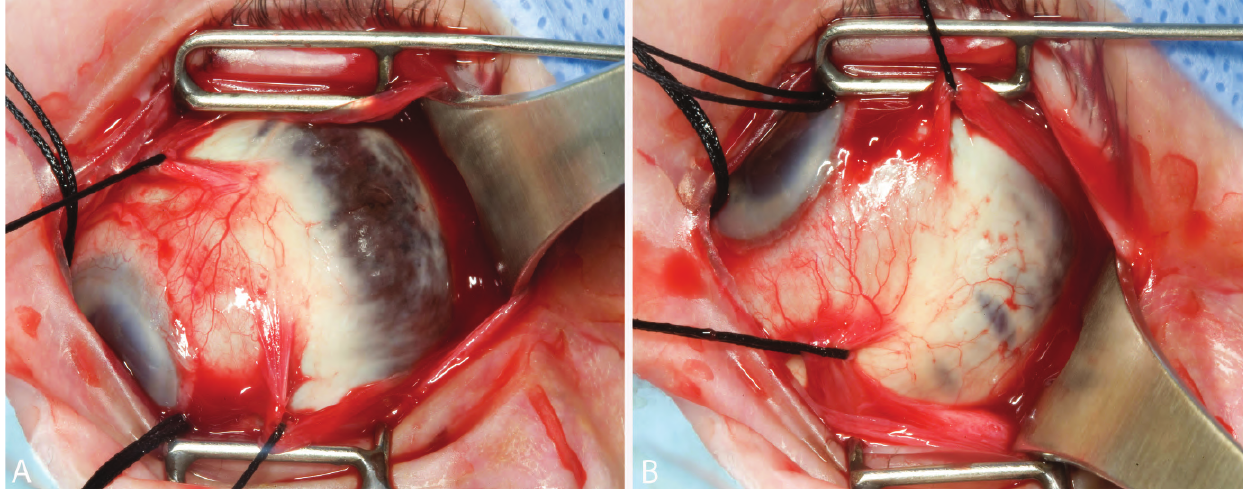
Figure 1. Intraoperative external photograph of an 80-year-old female during placement of a scleral buckle showing extensive scleral thinning in the superotemporal quadrant (A). Additional scleral thinning was noted inferotemporally as well (B).